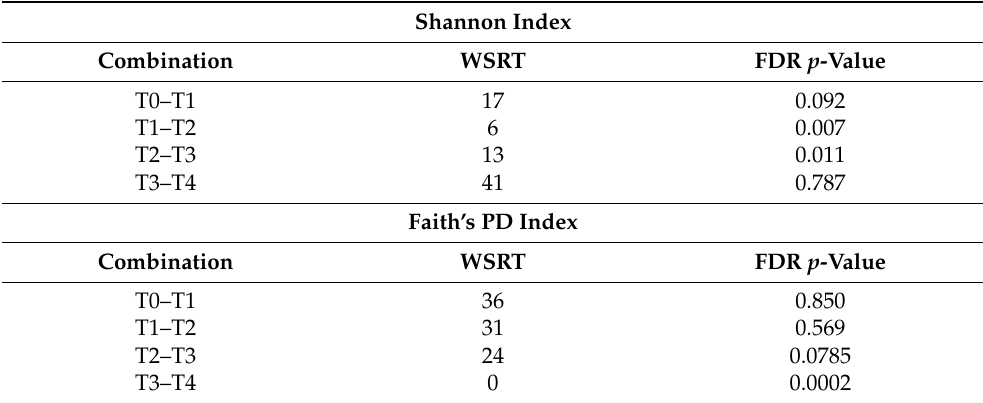
Table 1. Statistical analysis of the effect of aging on alpha diversity based on Shannon diversity index (on the top) and Faith’s phylogenetic distance (on the bottom).